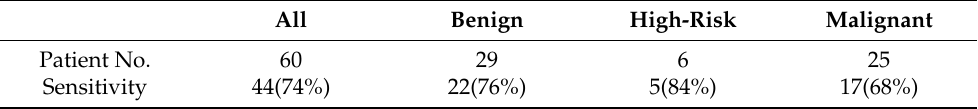
Table 2. Large Breast Analysis. All Benign High-Risk Malignant Patient No. 60 29 6